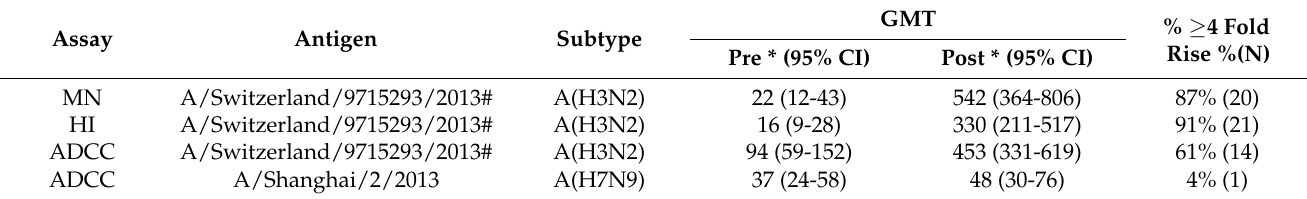
Table 4. HA-mediated ADCC antibody responses to A(H7N9) and A(H3N2) viruses following seasonal IIV3 vaccination in